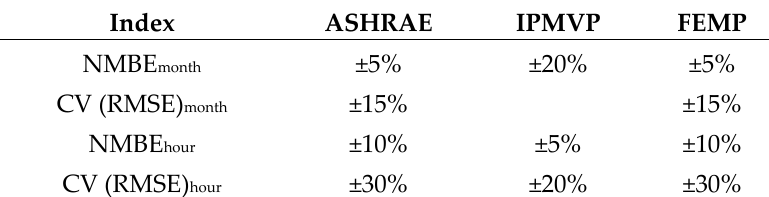
Figure 1. Building Model created in eQUEST [7]. Table 2. Commonly used calibration criteria